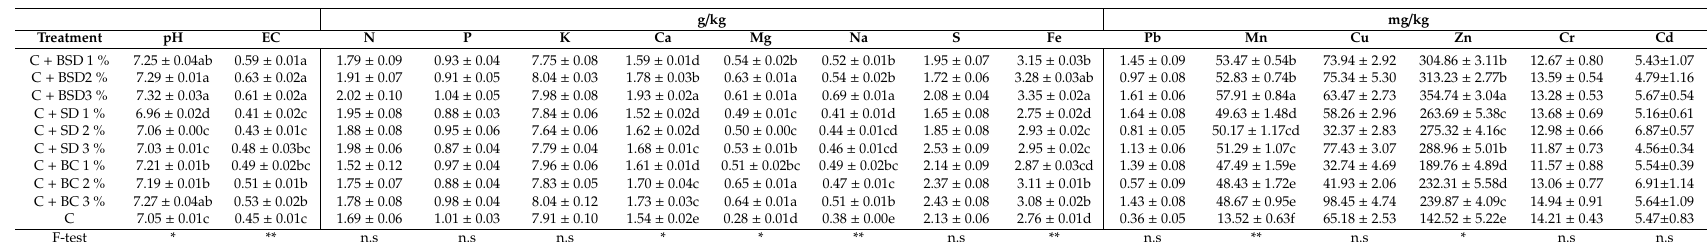
Table 2. Chemical properties of soil (C) and soil after amendment addition in maize cultivation ± standard